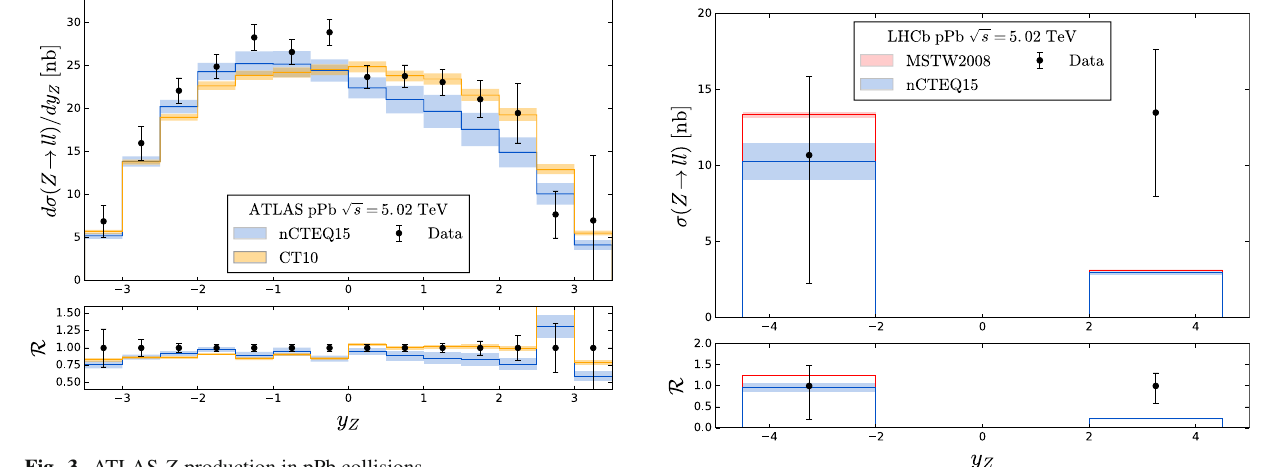
Fig. 3 ATLAS Z production in pPb collisions